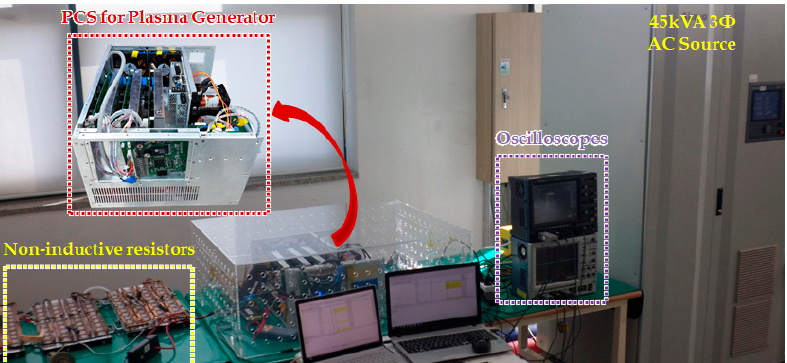
Figure 8. Experimental environment.